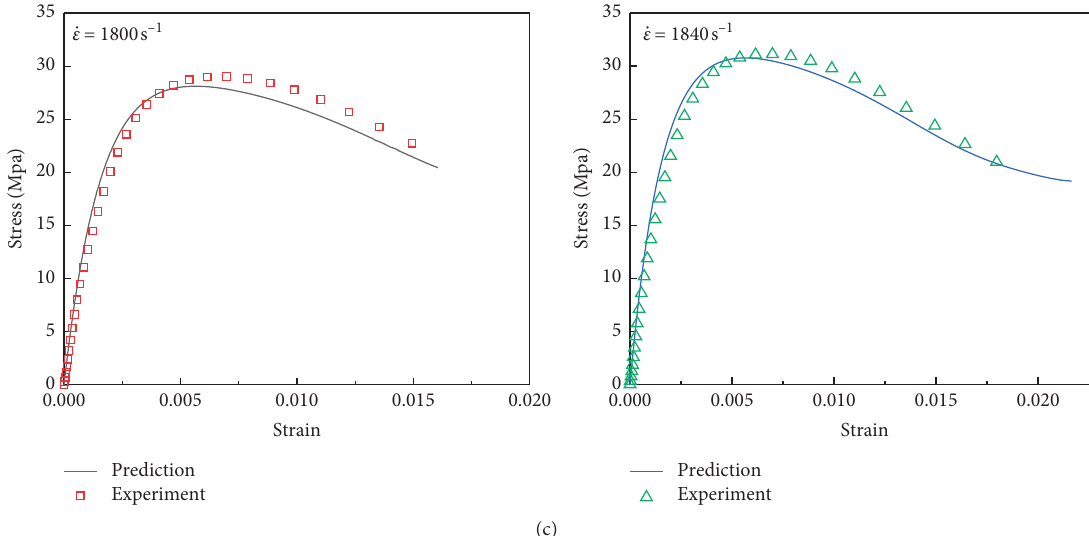
Figure 11: The comparison between the calculated results and the experimental results: (a) _ ε � 1000s − 1 and _ ε � 1160s − 1 in the first region; (b) _ ε � 1520s − 1 and _ ε � 1630s − 1 in the second region; (c) _ ε � 1800s − 1 and _ ε � 1840s − 1 in the third